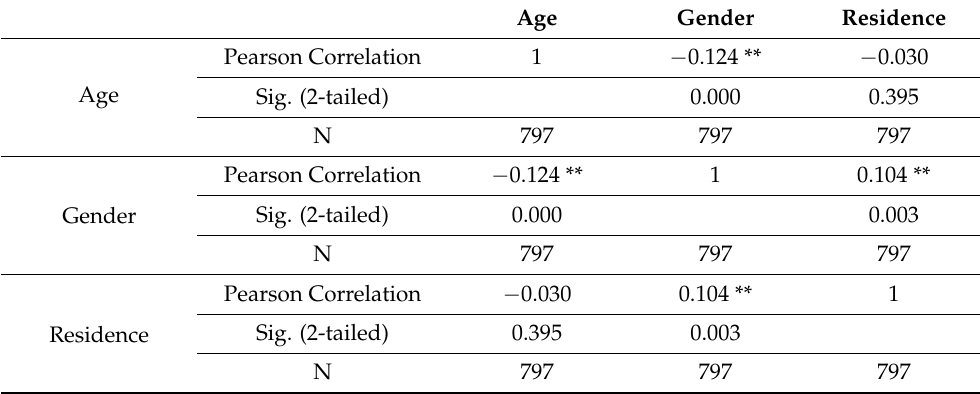
Table 2. Correlation age-residence-gender in the study group.